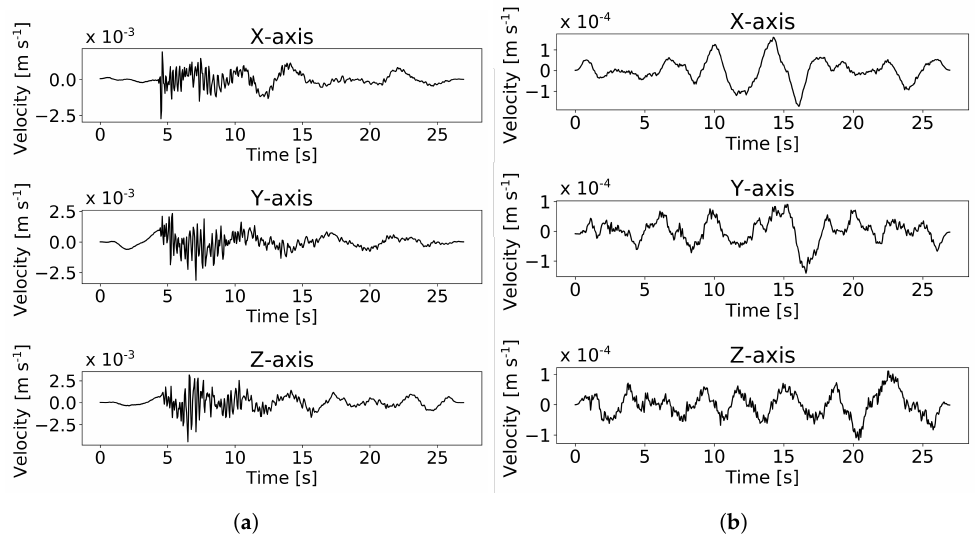
Figure 2. Two randomly sampled seismogram instances from the LEN-DB dataset, depicting ( a ) an event (earthquake) and ( b )